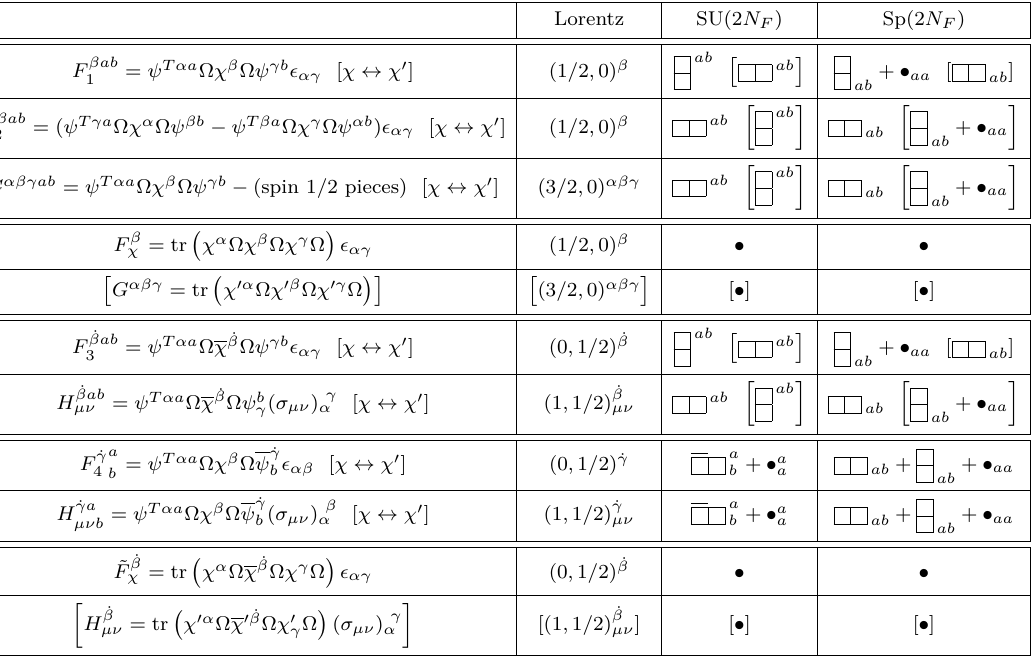
Table 2 . The fermion-trilinear operators, and their transformation properties with respect to Lorentz and to the flavour symmetry, before and after SSB. HC indexes (not shown) are contracted according to eqs. (A.2) and (A.3). The case when χ ij antisymmetric is replaced by χ 0 shown in squared brackets